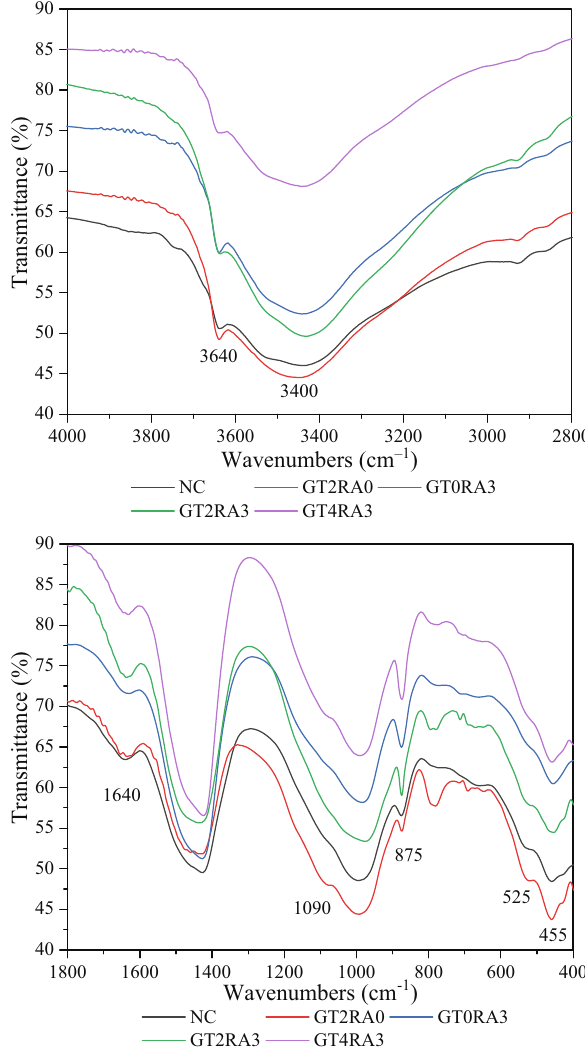
Figure 16: Functional group analysis on